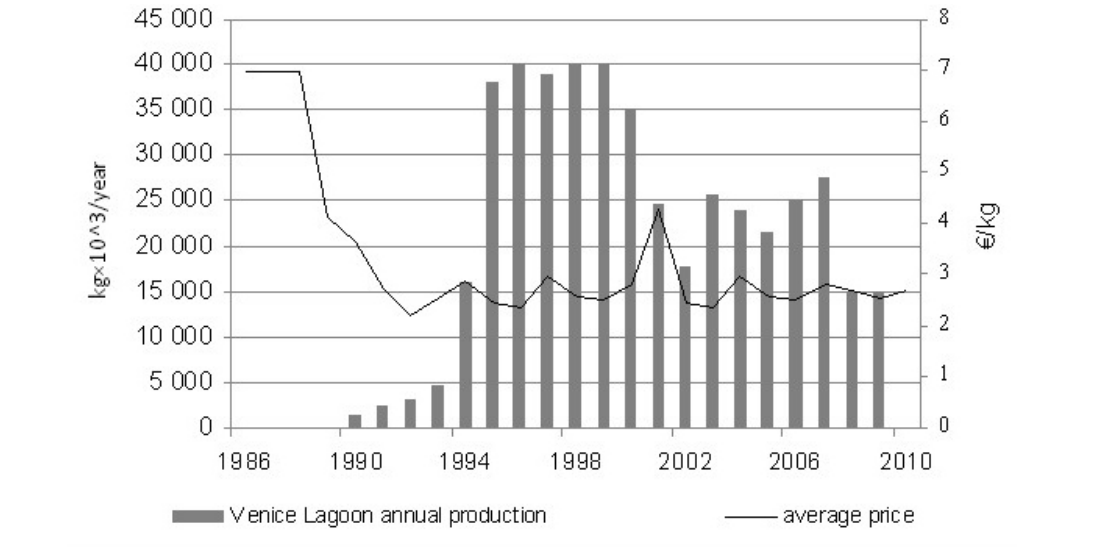
Fig. 1. Time course of clam production (first axis) and market price (second axis) in the Venice Lagoon (Zentilin et al. 2008; Dr. Chiaia, GRAL, personal communication